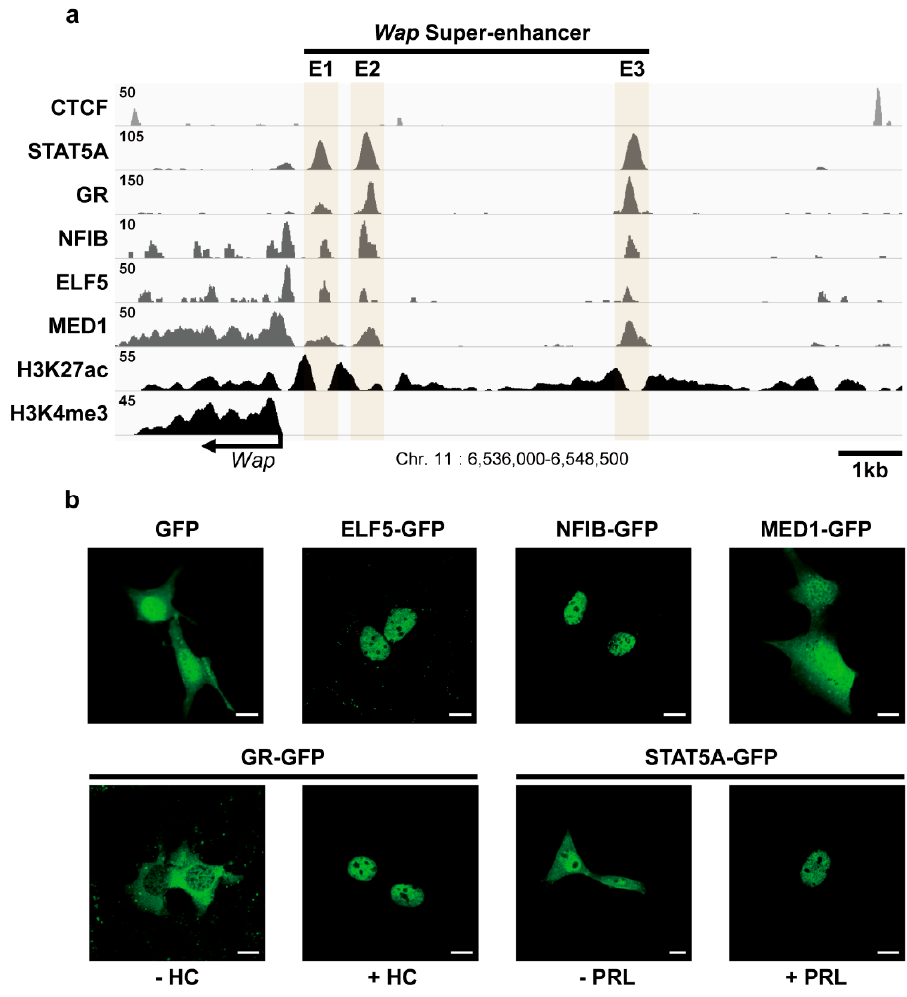
Figure 1. Characterization of mammary-enriched transcription factors constituting the Wap super- enhancer. ( a ) Genomic features of the super-enhancer in the Wap locus. ChIP-seq profiles of the transcriptional insulator, CTCF; the mammary-enriched transcription factors, STAT5A, GR, NFIB, and ELF5; the mediator, MED1; and the active histone marks, H3K27ac and H3K4me3. ( b ) Cellular localization of GFP-linked ELF5, NFIB, MED1, GR, and STAT5A in HC11 mammary epithelial cells. Representative fluorescence images from three independent experiments are shown (800×). After serum starvation, cells were left untreated or were treated with hydrocortisone (HC) or prolactin (PRL) to activate GR or STAT5A, respectively. Scale bars, 10 μ M.